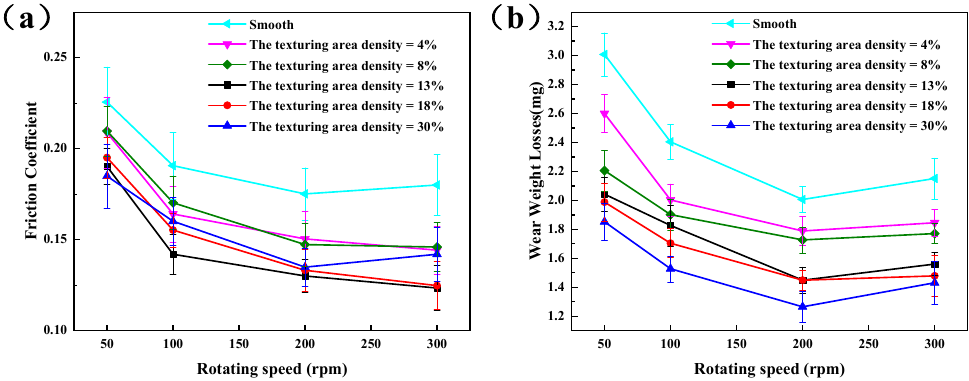
Figure 9. E ff ect of di ff erent texture densities on friction coe ffi cient and wear-weight loss under the Figure 9. Effect of different texture densities on friction coefficient and wear-weight loss under the constant 300N load: ( a ) friction coe ffi cient, and ( b ) wear-weight constant 300N load: ( a ) friction coefficient, and ( b ) wear-weight losses.